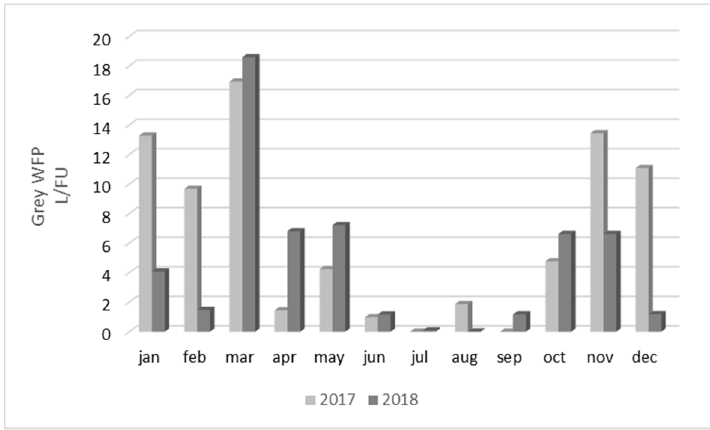
Table 3. Vineyard direct water footprint components for case study I and case study II, in 2017 and 2018.